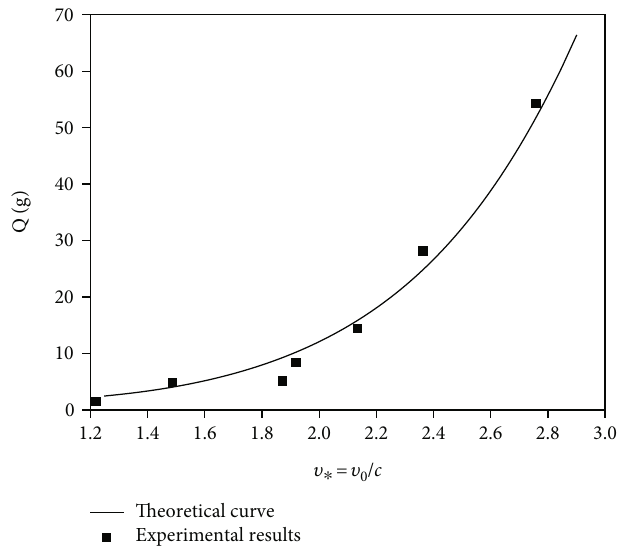
Figure 6: Experimental and theoretical equivalent charge Q vs. scale velocity υ